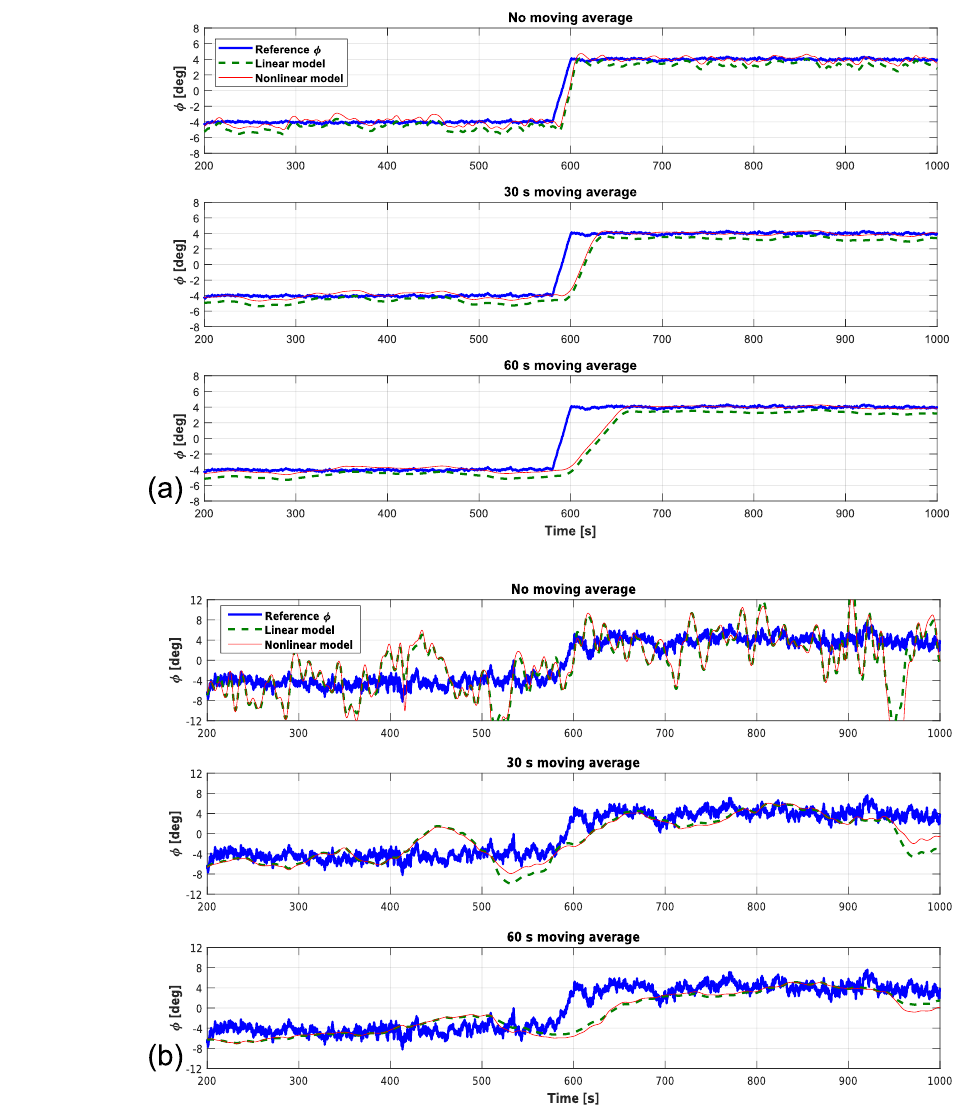
Figure 19. Yaw misalignment for an 8 ◦ change in wind direction at 7ms − 1 with 2% (a) and 20% (b) TI. Solid thick blue lines: real yaw misalignment; dashed thick green lines: estimate by the linear model; solid thin red lines: estimate by the nonlinear